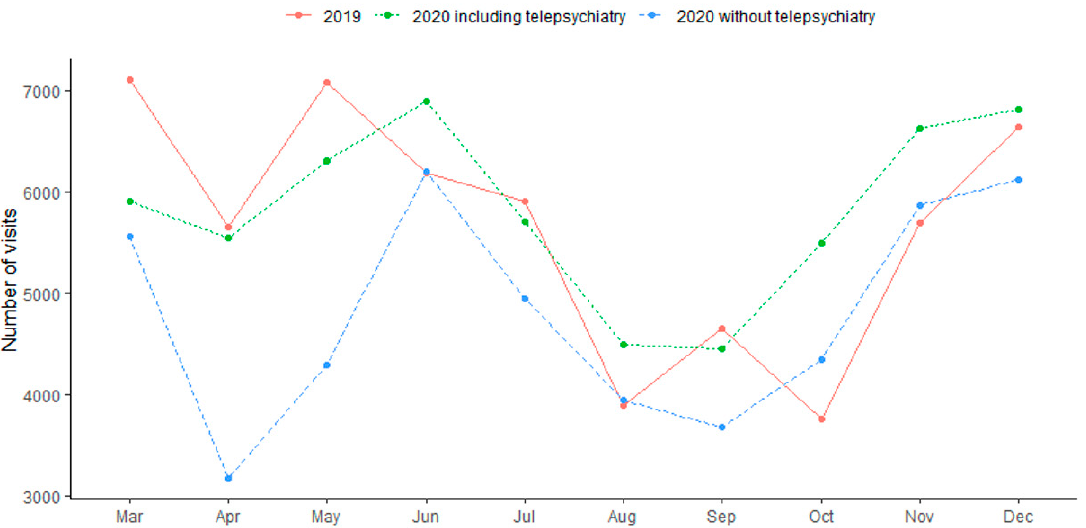
Figure 2. Monthly visits in 2019 as compared to 2020 (stratified with and without telepsychiatry).